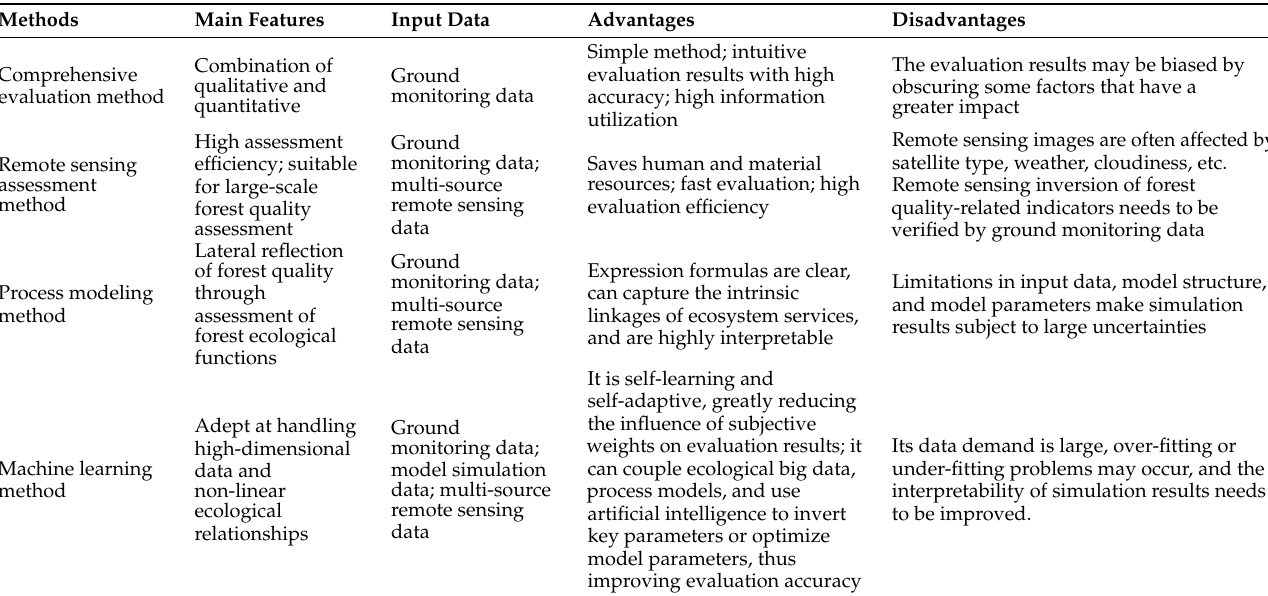
Table 2. Comparison of forest ecosystem quality assessment